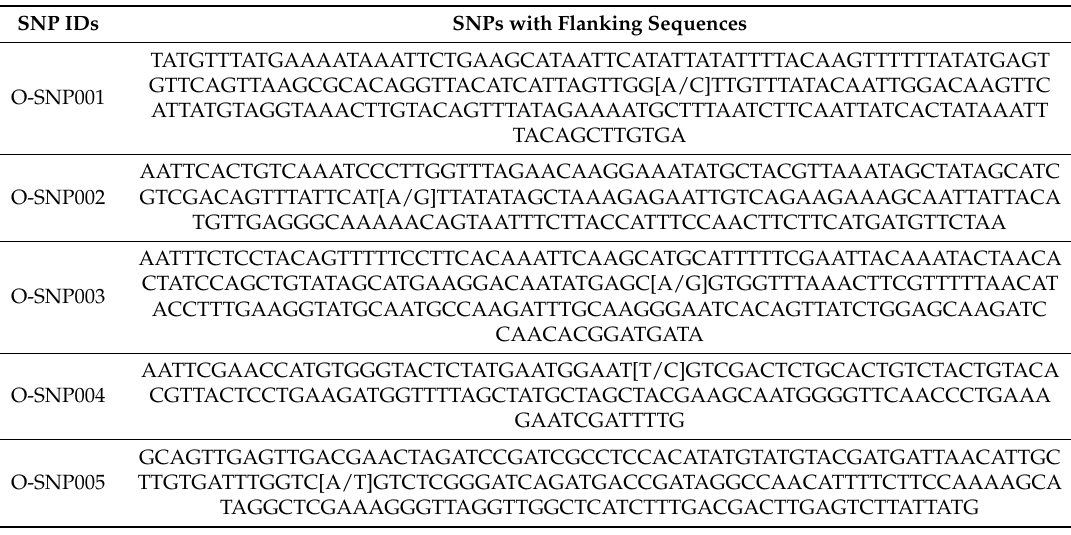
Table 2. The flanking sequences and single nucleotide polymorphisms (SNPs) of the 48 polymorphic markers. SNP IDs SNPs with Flanking